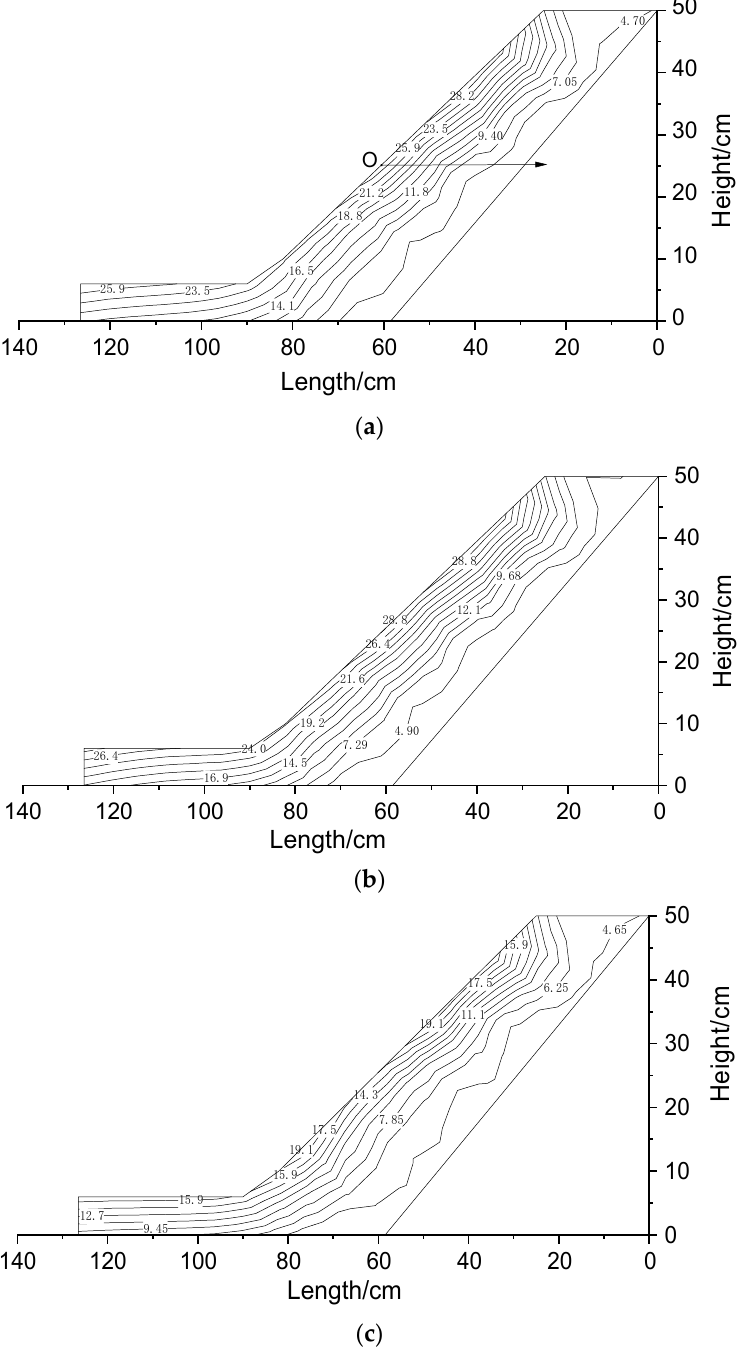
Figure 6. Contour of mass moisture content in the back fi ll slope: ( a ) T − 2; ( b ) T − 3; and ( c ) T − 4.